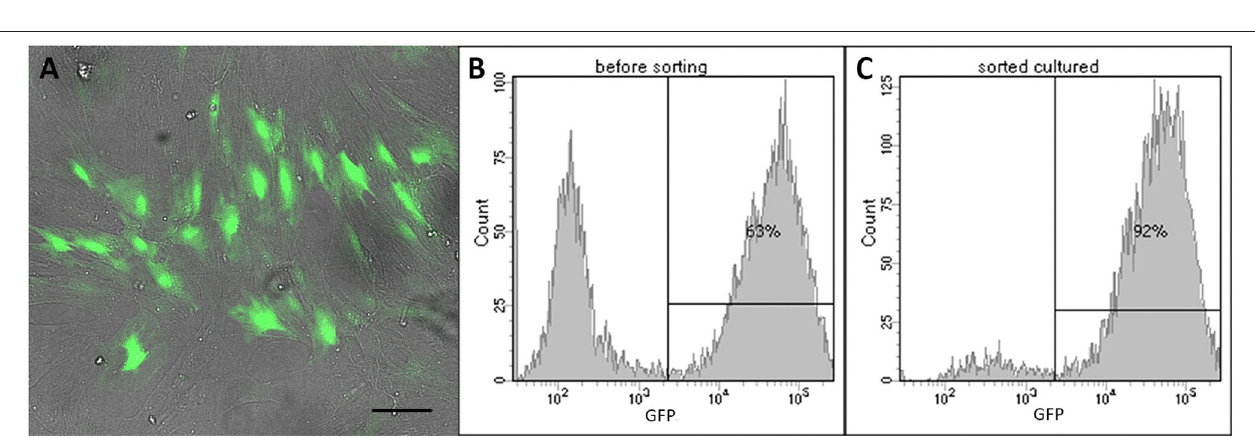
of fibrin glue with large-sized cells and clearly visible nuclei on its surface were found in the AG + FG + ADSCs group ( Figure 7C